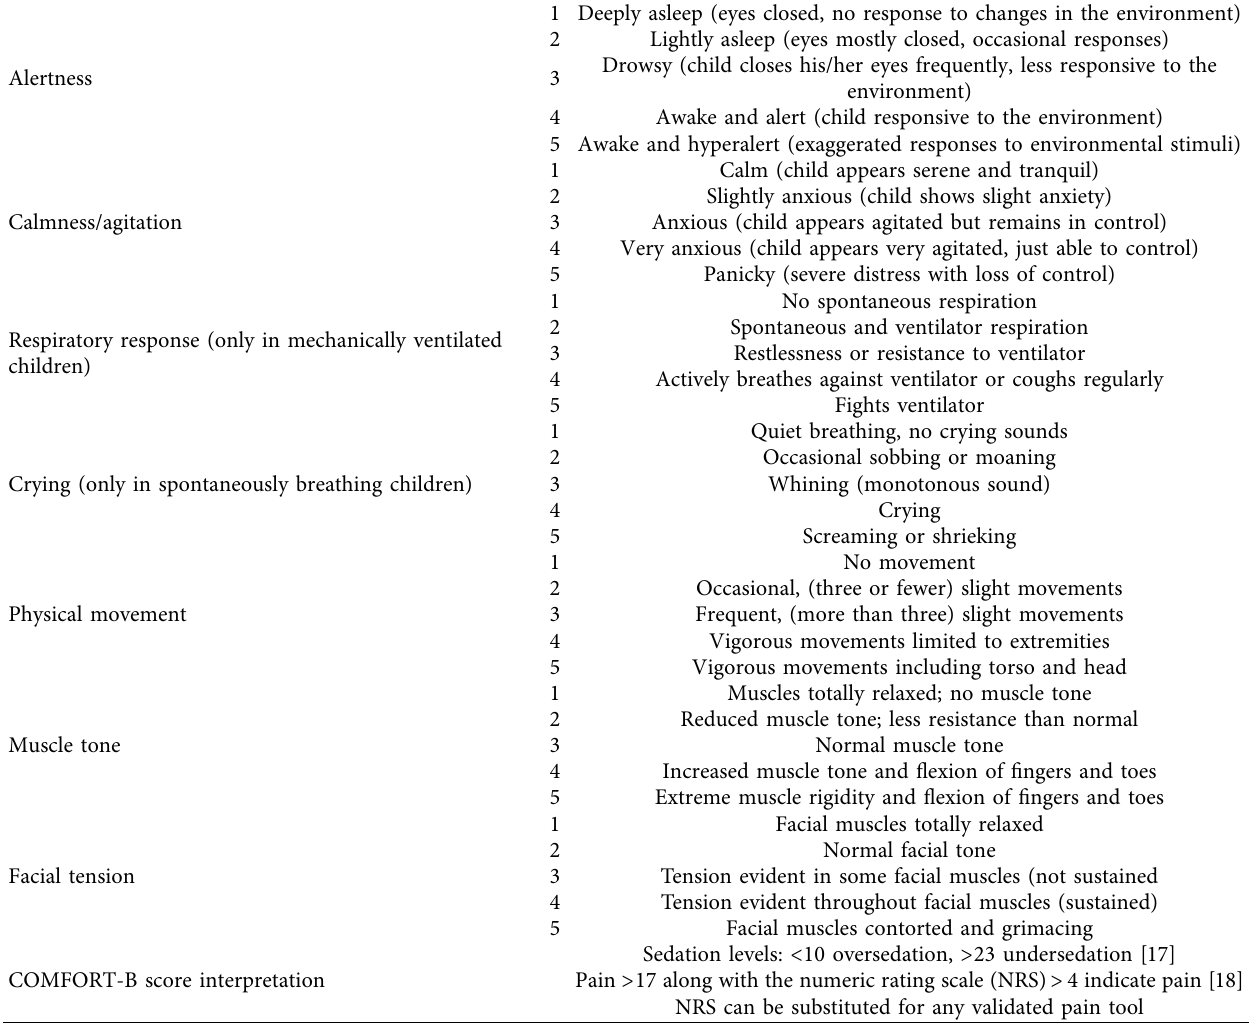
Table 2: Scoring and interpretation for the COMFORT-B scale. When performing the assessment, the infant is observed for 2 minutes. The healthcare professional must be in a position that permits a full view of the infant’s face and body [17, 18]. 1 Deeply asleep (eyes closed, no response to changes in the Alertness